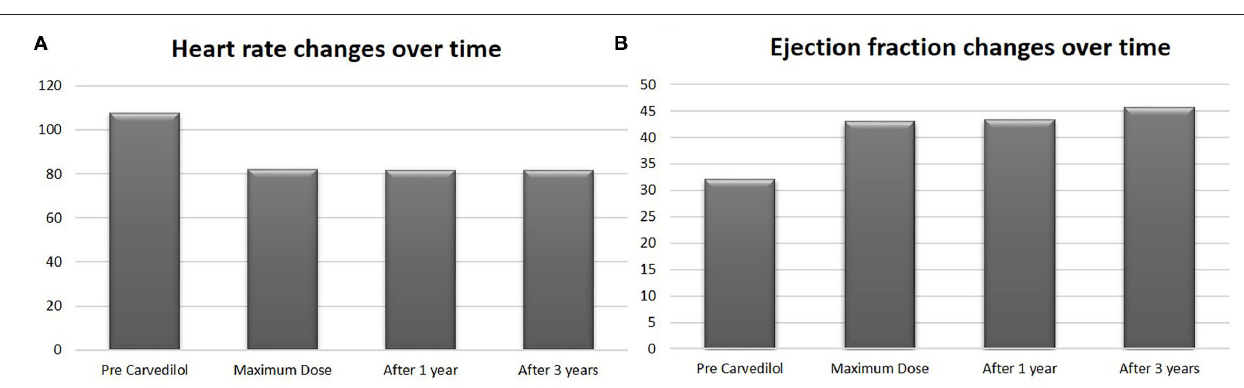
FIGURE 4 | Heart rate and ejection fraction values in carvedilol group at baseline, at maximum dose, after 1 year and after 3 years of follow-up. Values are represented by mean.